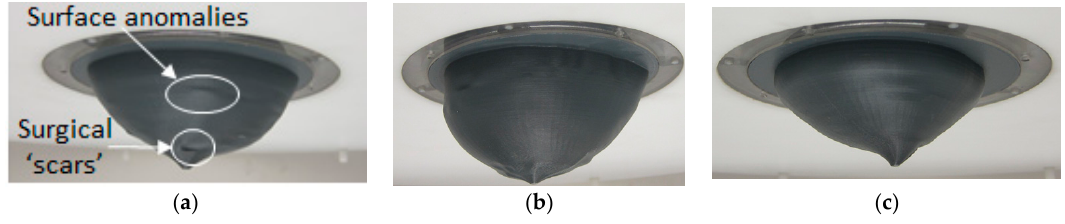
Figure 4. Surface models fitted into top lid of the prototype shown in Figure 1. Model A, B, and C in ( a – c ), respectively.